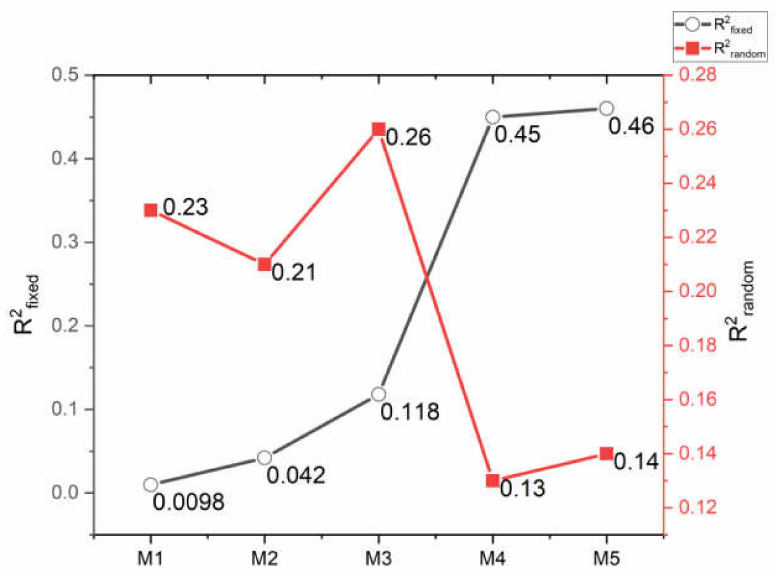
Figure 7. Comparison of changes in R 2 among different schemes (R 2 fixed : Proportion of variance in the COVID-19 incidence rate explained by the fixed effect terms; R 2 random : Proportion of variance explained the random effect term of cities’